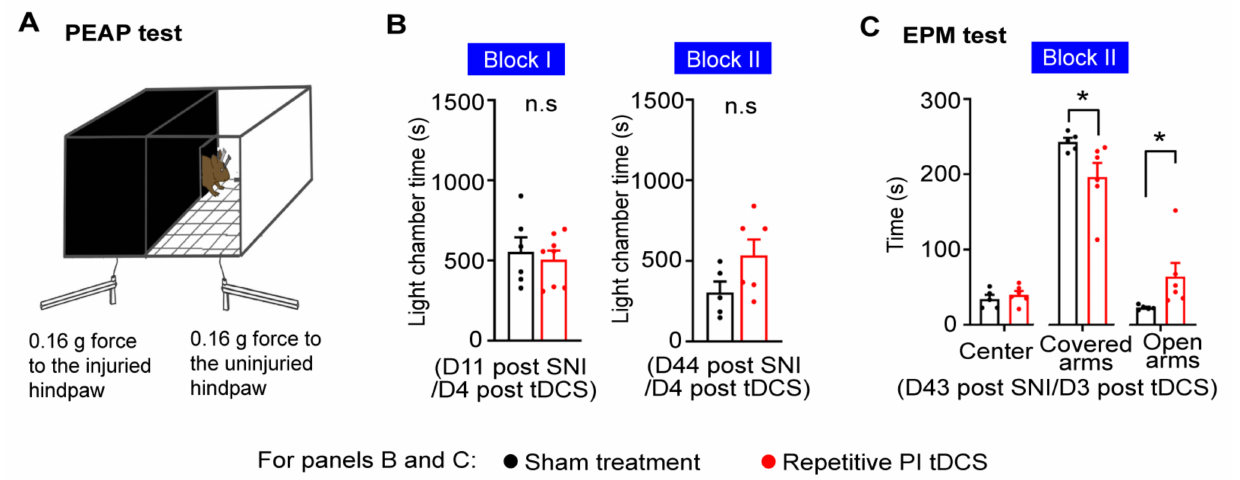
Figure 3. Impact of repetitive PI tDCS on the aversive component of neuropathic pain and pain- related anxiety-like behavior. ( A ) Scheme of the place escape avoidance paradigm (PEAP test), which tests aversion to low intensity von Frey force in neuropathic mice with mechanical allodynia. ( B ) Quantitative summary of time spent in the light chamber (i.e., avoiding the dark side of the chamber). ( C ) Analysis of anxiety-like behavior in neuropathic mice, demonstrated by more time spent in closed arms than in open arms of the elevated maze. For panel ( B ), Block I: n = 6 in sham treatment group and n = 8 in PI tDCS group, in panels ( B , C ), Block II: n = 5 in sham treatment group and n = 6 in PI tDCS group; repeated ANOVA measurements with Sidak’s multiple comparisons test and the Mann-Whitney test were performed; * p < 0.05 as compared to the sham treatment group. n.s.: non-significant. Data are represented as mean ±